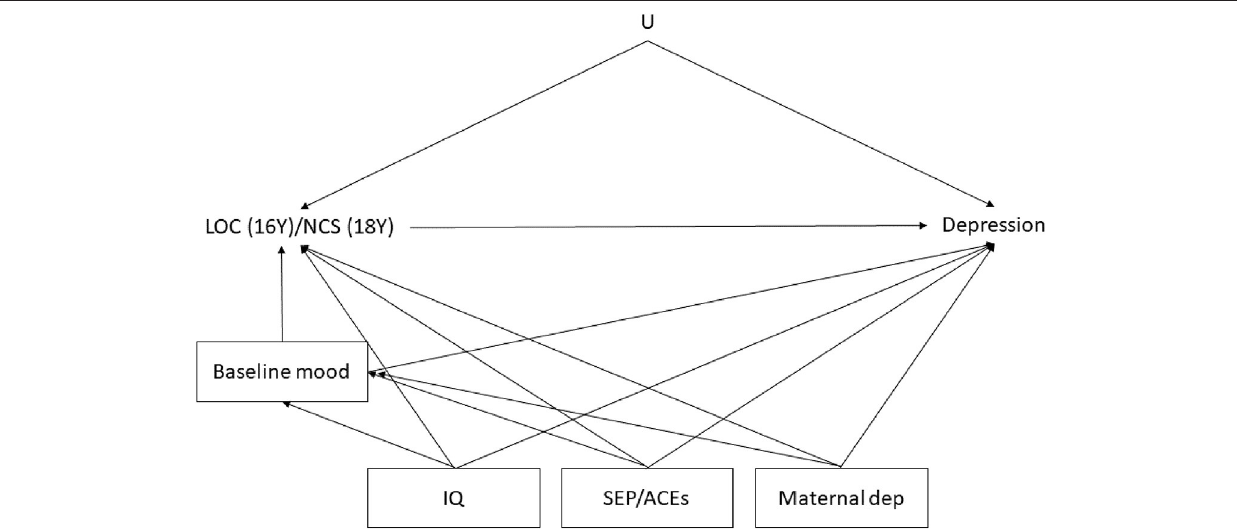
FIGURE 2 | Directed Acyclic Graph (DAG) representing hypothesized causal relationship between our exposures (locus of control and negative cognitive styles) and our outcome (depression). “U” represents the unmeasured/unknown confounding factors which we cannot adjust for. In the Locus of control model, baseline depression and anxiety were measured with the SMFQ and the GAD subscale of DAWBA, respectively. In the Negative Cognitive Styles model, baseline depression and anxiety were measured with depression and anxiety subscale of CIS-R at 18 years old. Depression represents the outcomes which was measured with the SMFQ at 23 years of age. IQ was measured at 8 years old as a total score derived by the Wechsler Intelligence Scale for Children, Socio Economic Position related variables included: maternal education, maternal social class and a continuous score of the Adverse Childhood Experiences (ACE) variables, sex. “Maternal Dep” stands for the maternal (ALSPAC-G0) depression during pregnancy measured with the EPDS. Correlations between confounding factors are not represented for